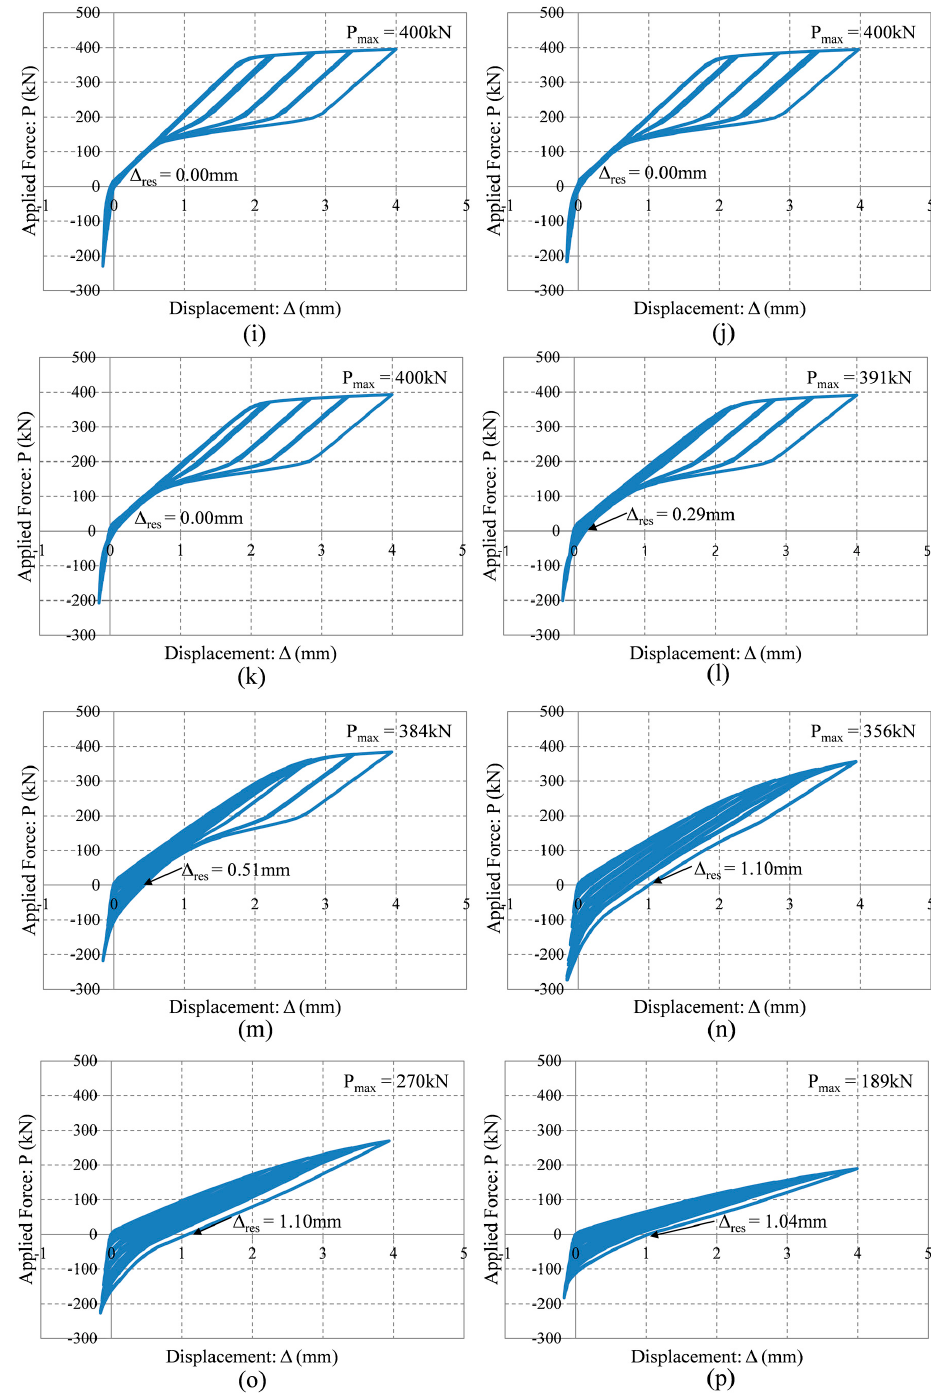
Figure 11. Total displacement and force curves for the 16 model cases: ( a ) Case-1 ( α = − 0.60); ( b ) Case-2 ( α = − 0.48); ( c ) Case-3 ( α = − 0.31); ( d ) Case-4 ( α = − 0.06); ( e ) Case-5 ( α = 0.25); ( f ) Case-6 ( α = 0.74); ( g ) Case-7 ( α = 1.64); ( h ) Case-8 ( α = 3.58); ( i ) Case-9 ( α = 0.09); ( j ) Case-10 ( α = 0.22); ( k ) Case-11 ( α = 0.40); ( l ) Case-12 ( α = 0.66); ( m ) Case-13 ( α = 1.06); ( n ) Case-14 ( α = 1.74); ( o ) Case-15 ( α = 2.98); ( p ) Case-16 ( α =